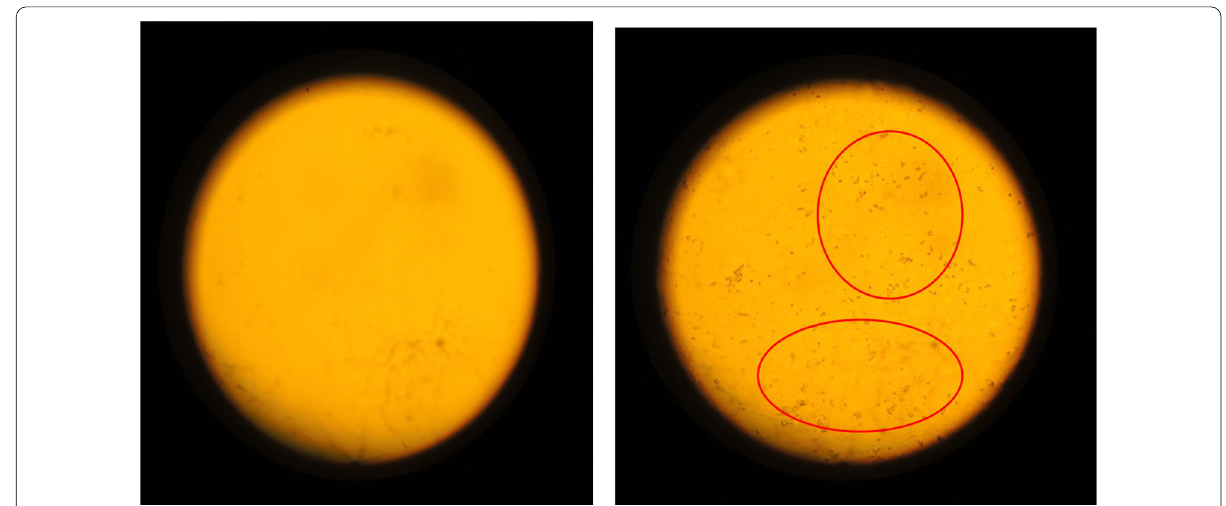
Fig. 3 Microscope image showing untreated (left) and plant extract treated (right) S. typhi cells after PI staining. The number of dead cells (encircled in red) is significantly higher in the 24-h plant extract treated cells indicating the inhibitory action of the